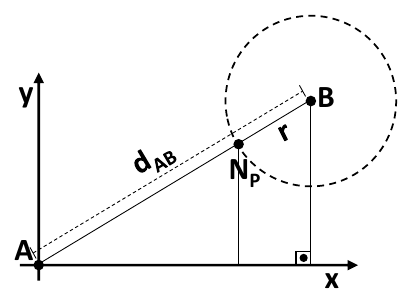
Figure 2. Nearest point geometrical representation.